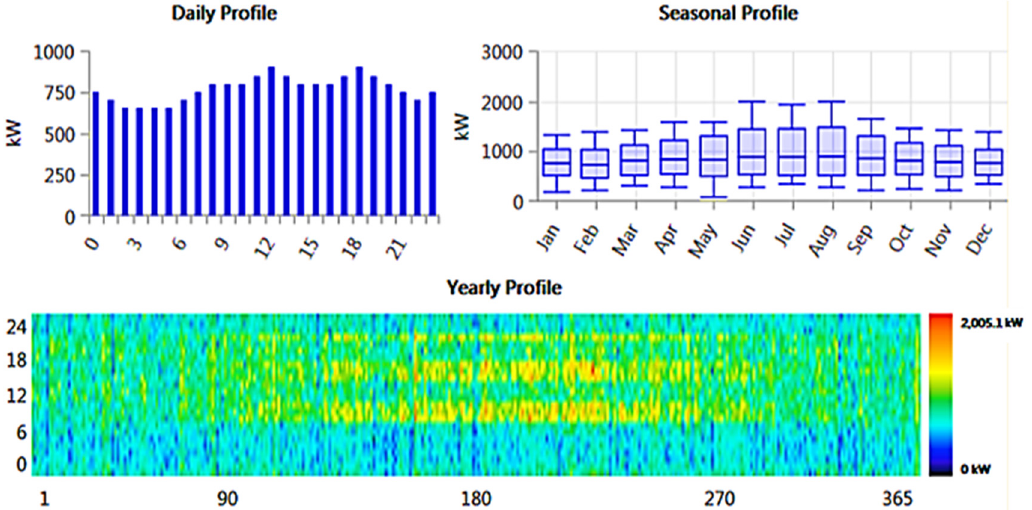
Figure 3. The first day of January, seasonal and yearly baseline load